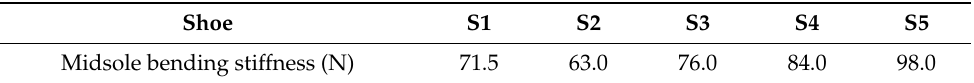
Table 1. Shoes used in this study with different midsole bending stiffnesses. All shoes were men’s size 8 Puma shoes. Required force to bend the shoe in the forefoot area 45